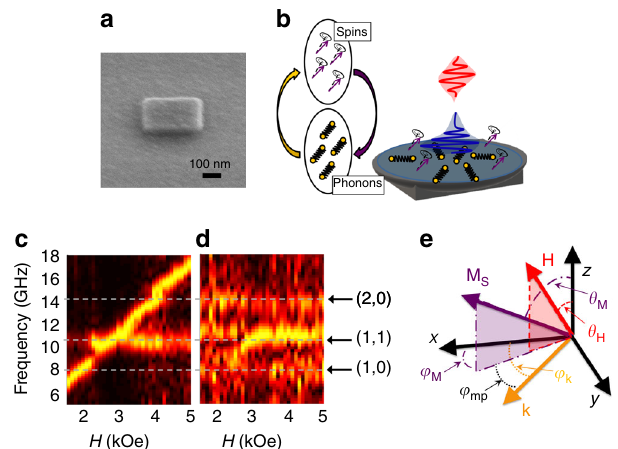
Fig. 1 Experimental illustrations and colormaps. a Scanning electron microscope image of 330 x 330 x 30 nm Ni nanomagnet. b When the pump pulse (400 nm) irradiates the sample, the deposited heat causes the element to thermally expand, which causes the element to vibrate at eigenfrequencies determined by the geometry and material properties. In addition, the heat perturbs the magnetization causing the spins to precess around the effective fi eld. Due to magnetostriction, the spin and phonon systems are coupled to one another. A probe pulse (800 nm) which is delayed in time monitors the dynamics following excitation. c Fourier amplitude spectra normalized for each fi eld bin of the magnetic and ( d ) the non-magnetic detection channels. The arrows and dotted lines are indicators of the phononic eigenfrequencies. The positions of these frequencies match in the magnetic and non-magnetic spectra. e Experimental geometry. The x and y axes are de fi ned to be the in-plane directions along the edges of the nanomagnet and the z -axis in the direction of the surface normal. The external fi eld H is applied at θ H = 60° with respect to the surface normal. This cants the magnetization vector M S out of the plane to an angle θ M with respect to the surface normal and to an in- plane angle, φ M from the x -axis. The phononic modes k are characterized by their mode indices and their in-plane angle, φ k . φ mp is the in-plane angle between M S and